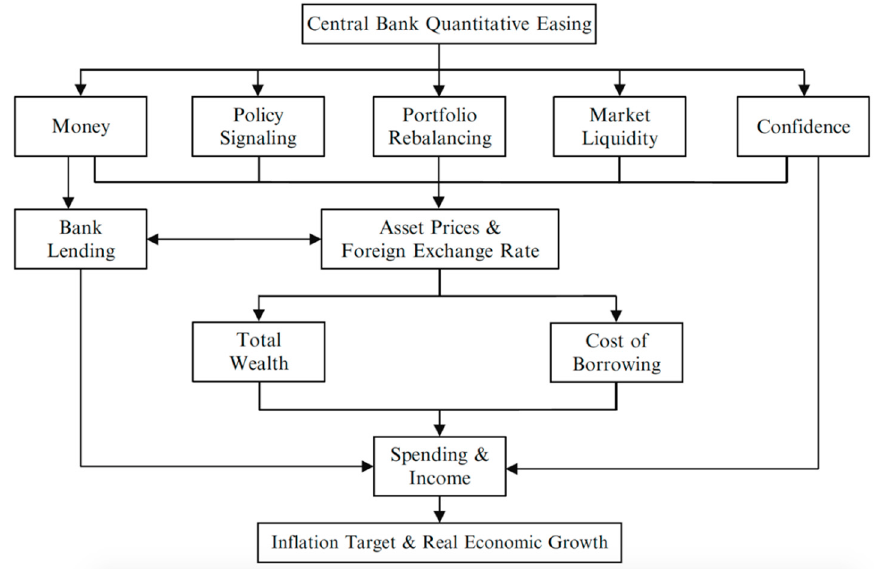
Figure 1. Transmission channels of quantitative easing (adopted from Joyce et al. (2011)).